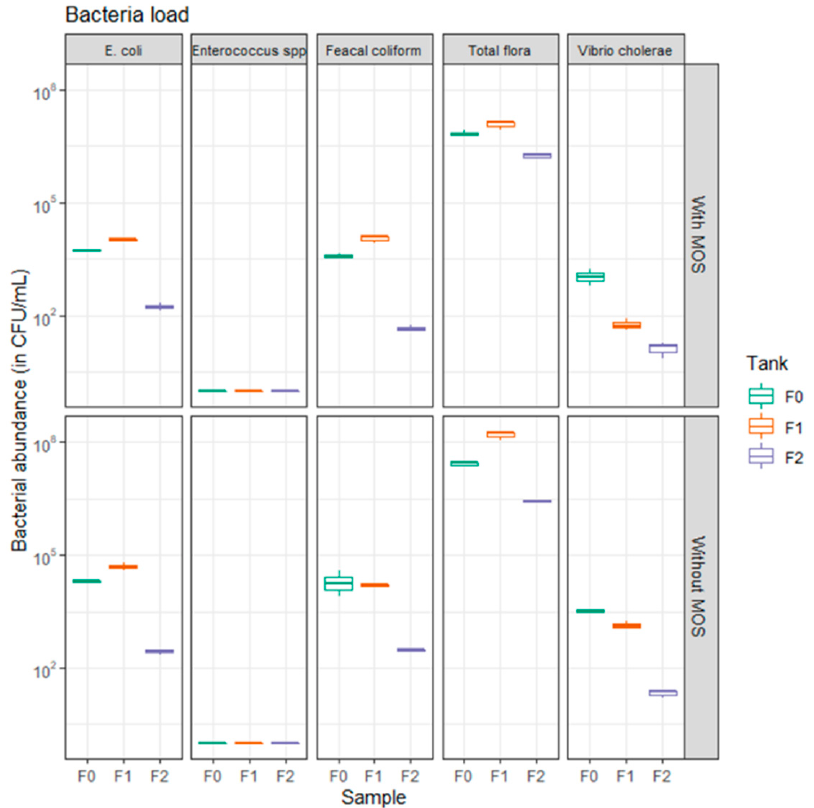
Figure 2. Abundances of bacteria in samples taken at the entrance of each tank for evaluation of abatement; counted number of bacteria represented as log 10 reduction.